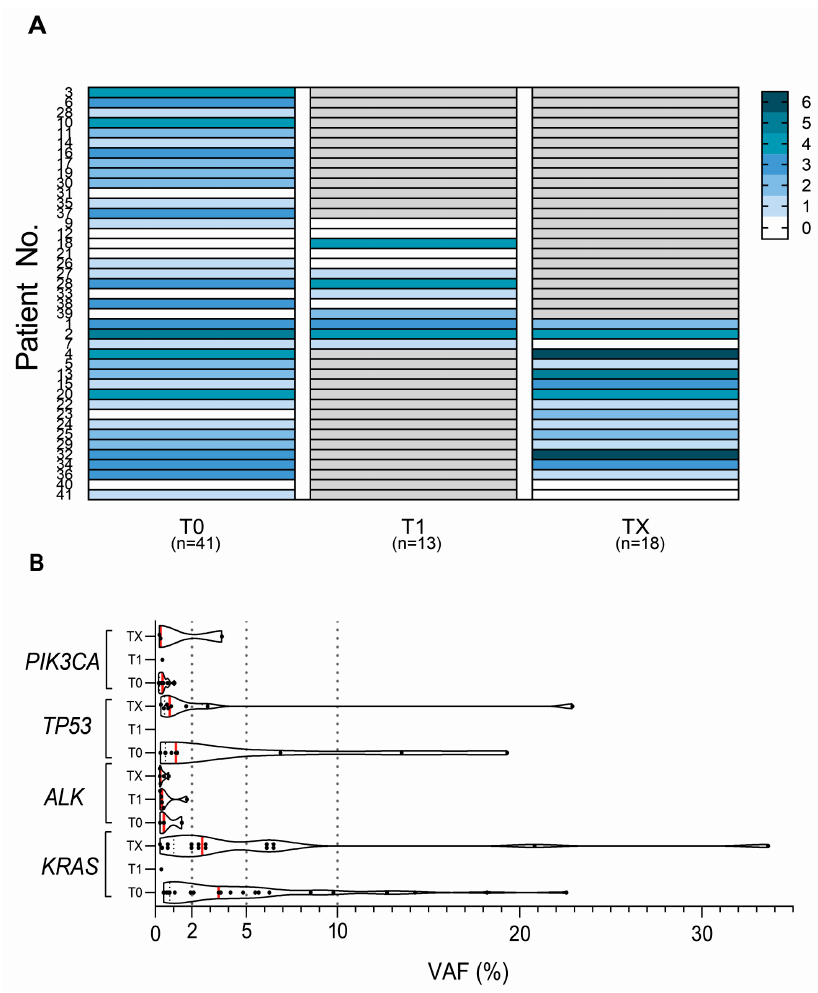
Figure 2. Changes in mutation count and variant allele frequency (VAF) according to sample collection time point in the T0, T1, and TX groups. ( A ) Mutation status and count distribution in T0, T1, and TX groups according to sample collection time; mutation count is color-coded in gradient from white—0 mutations to dark blue—6; grey—samples not collected. ( B ) Most frequently mutated actionable gene VAFs, according to sample collection time point in the T0, T1, and TX groups; each dot represents a sample, with violin plot corresponding to estimated density, and the median VAF is shown in a red vertical line; vertical do tt ed lines are at 2, 5, and 10% VAF.